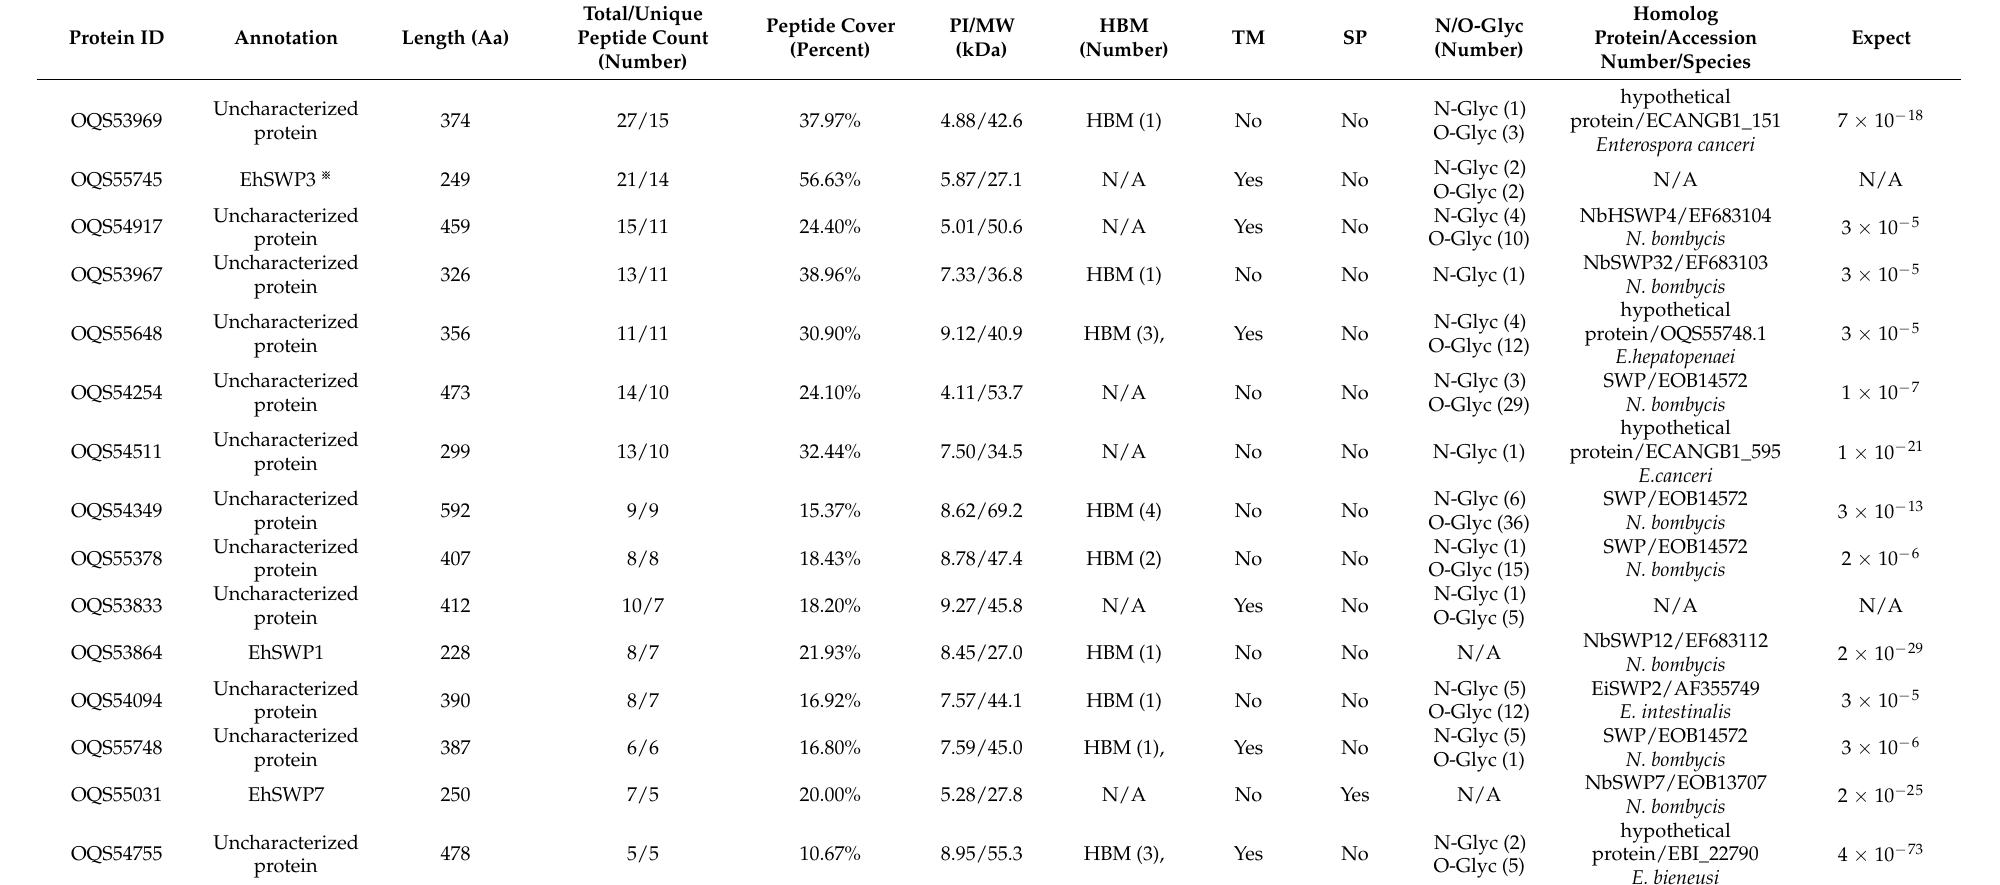
Table 2. Profile of 15 high-abundance surface proteins of Enterocytozoon hepatopenaei